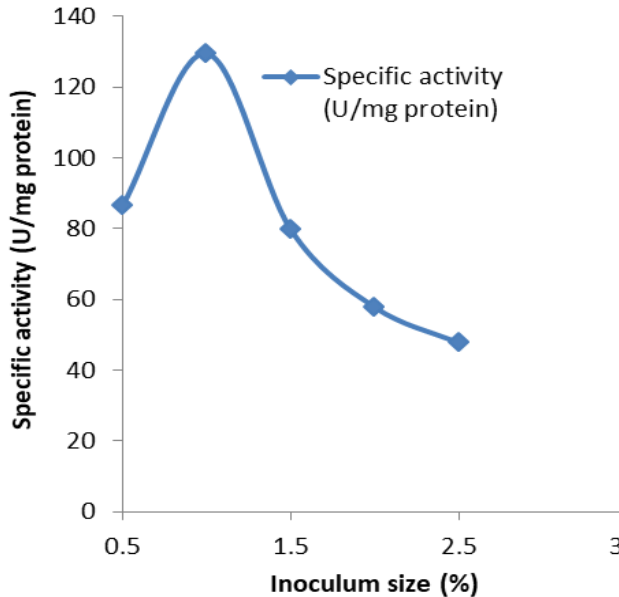
Figure 4: The optimum inoculum size for